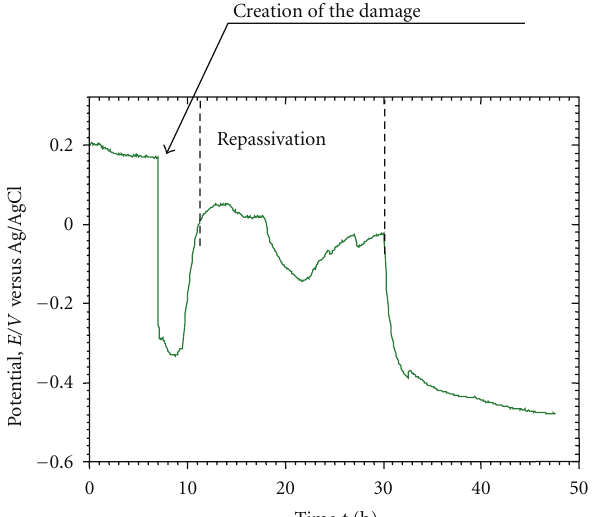
Figure 10: Potential change of steel covered by bilayered PPy film during the immersion in 3.5% NaCl solution. The damage was inserted on the PPy layer by a small knife in